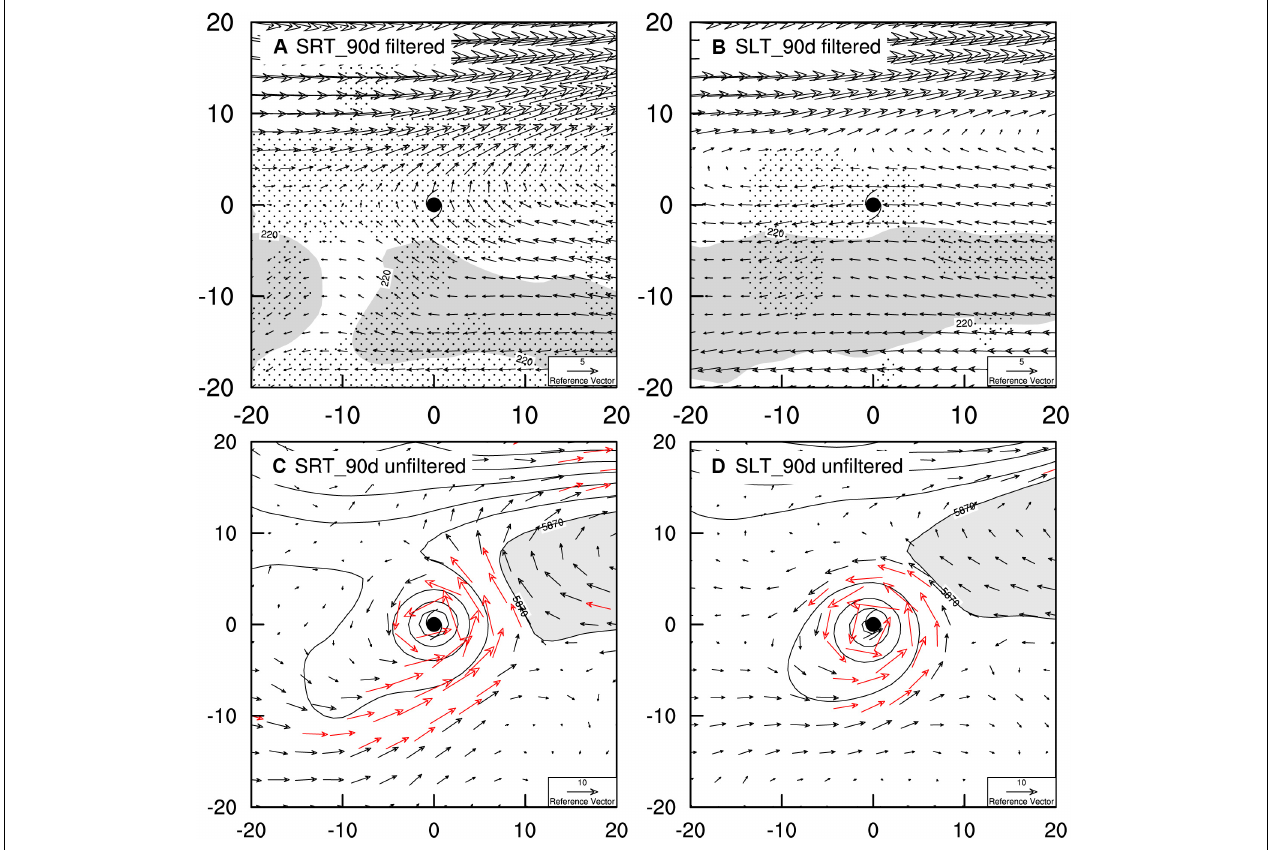
FIGURE 9 | (A,B) The composite filtered deep-layer averaged winds (vector, m s − 1 ) with the dotted area exceeding 95% significance, overlaid by the corresponding OLR field (shaded, W m − 2 ) and (C,D) unfiltered 700-hPa winds (vector, m s − 1 ), and 500-hPa geopotential height (contour, gpm) for the R90 and L90 cases at the turning time respectively. The gray areas in (A) and (B) indicate the corresponding filtered OLR less than 220 W m − 2 . Red vectors in (C) and (D) represent wind speeds larger than 8 m s − 1 and areas more than 5870 (gpm) in (C) and (D) are shaded. The coordinates are the latitudes and longitudes based on TC